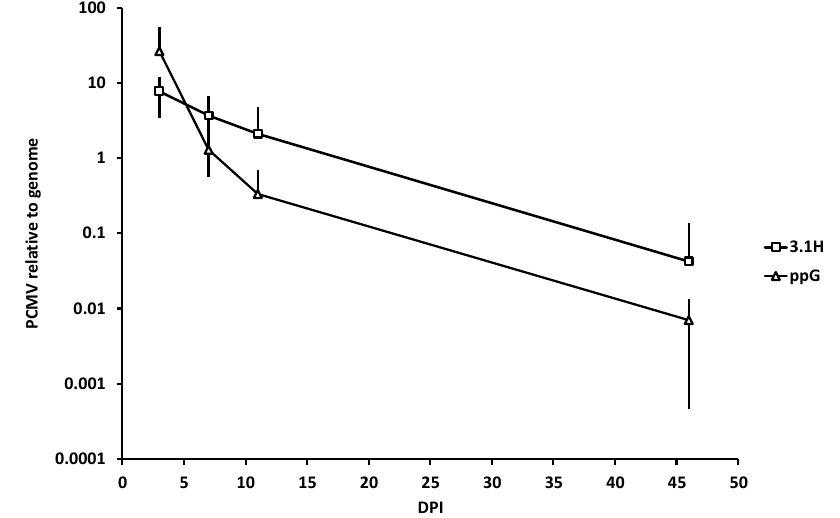
Figure 8. Comparison of the kinetics of the relative amount of plasmid at the site of injection in 3.1H and ppG-injected groups in experiment 1. Data represent average ± standard deviation (n = 6) of level of plasmid relative to the host genomic DNA. The scale is logarithmic. PCMV: CMV promoter, present in